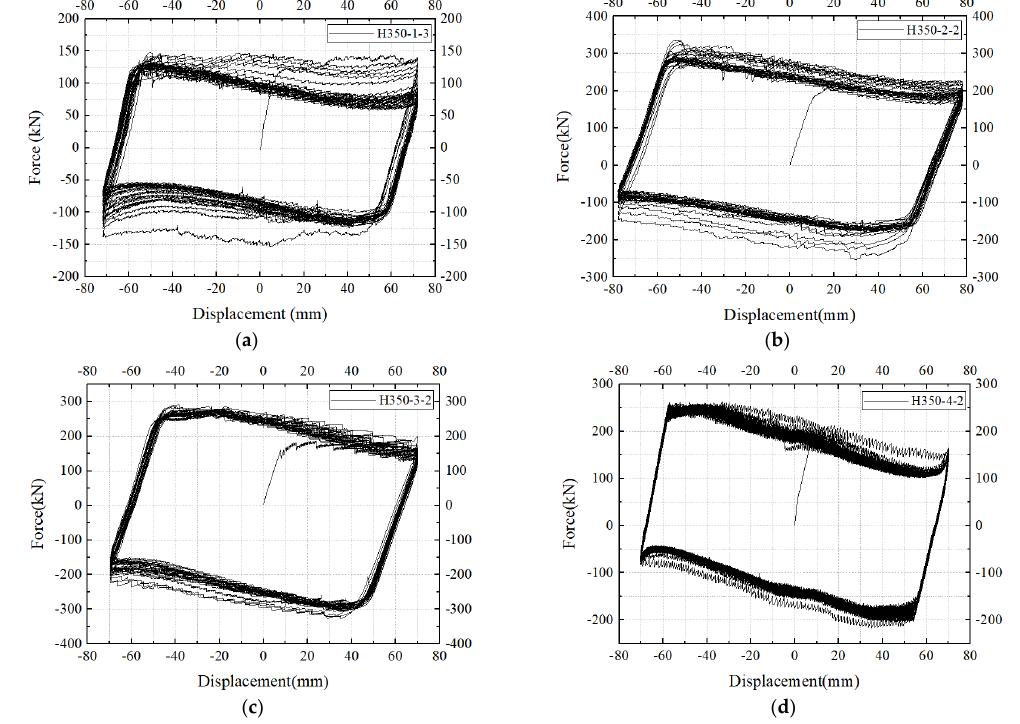
Figure 13. Force − displacement curves: ( a ) H350 − 1 − 2; ( b ) H350 − 2 − 2; ( c )H350 − 3 − 2; ( d ) H350 − 4 − 2.